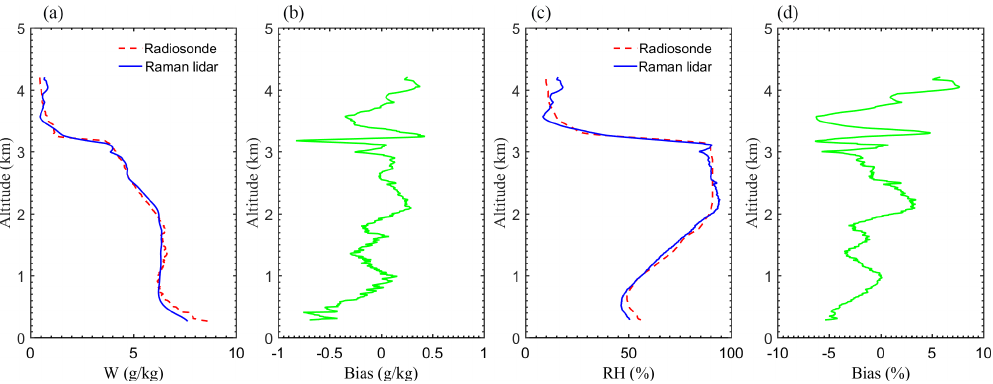
Figure 2. (a, c) Water vapor mixing ratio ( W ) and relative humidity (RH) profiles at 20:00CST 23 May 2016 retrieved by the Raman lidar (blue line) and the radiosonde (red dashed line), respectively, and (b, d) the absolute error in W and RH between the lidar and radiosonde retrievals (lidar minus radiosonde),